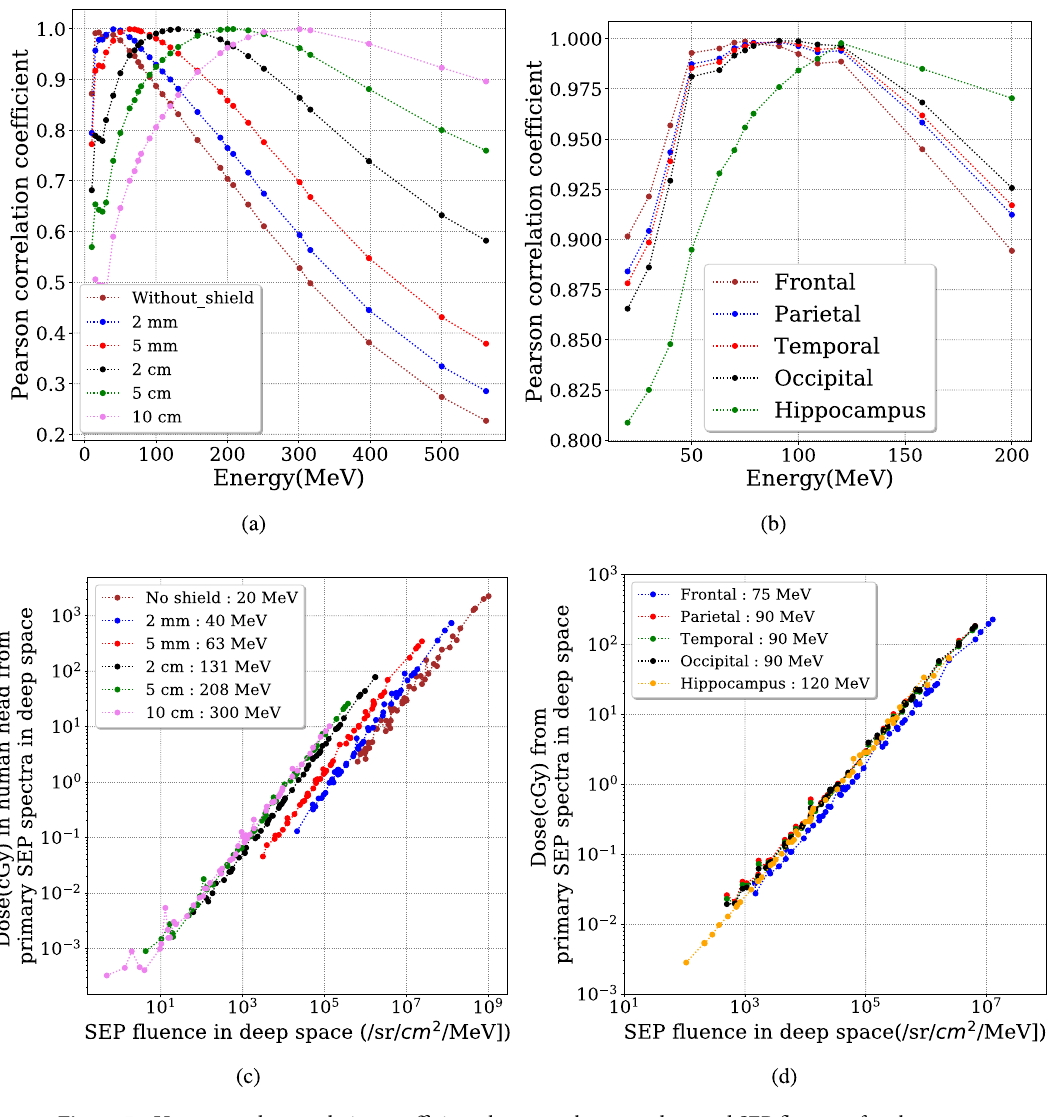
Figure 5. Upper panels: correlation coefficients between the event dose and SEP fluence of each event at different energies for ( a ) various thicknesses of Al around a human head and ( b ) different lobes of the human brain with 2 mm of Al shielding. Lower panels: The dose (cGy) deposit in a human head from primary SEP spectra in deep space versus SEP events fluence at the determined pivot energy for ( c ) a human head with different Al thickness and ( d ) different lobes of the brain under a 2 mm of Al